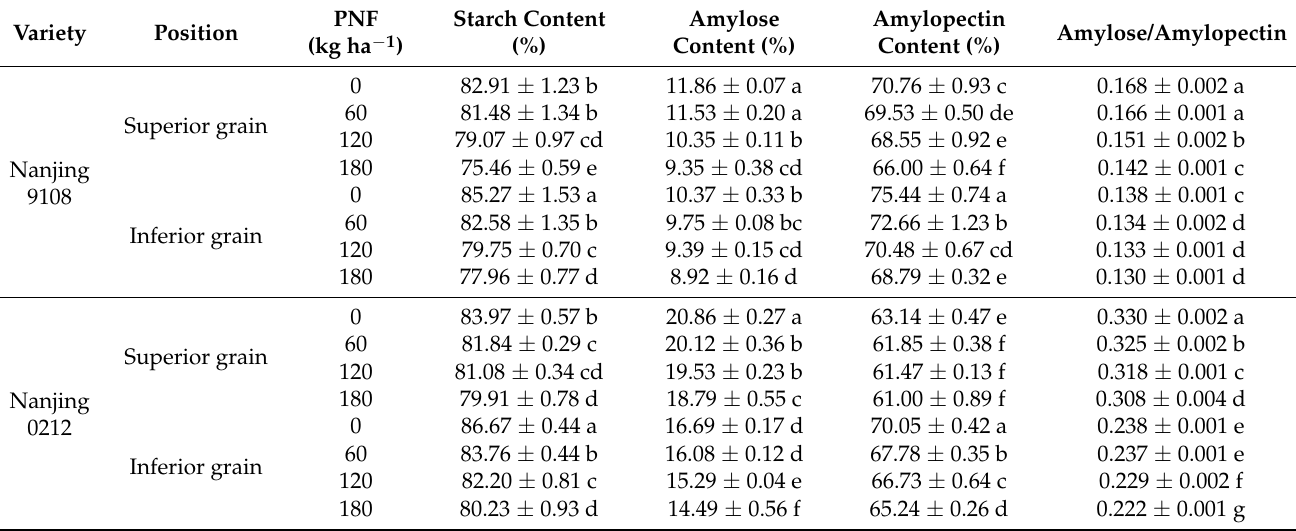
Table 1. Contents of total starch, amylose and amylopectin in superior and inferior grains of japonica rice under different PNF